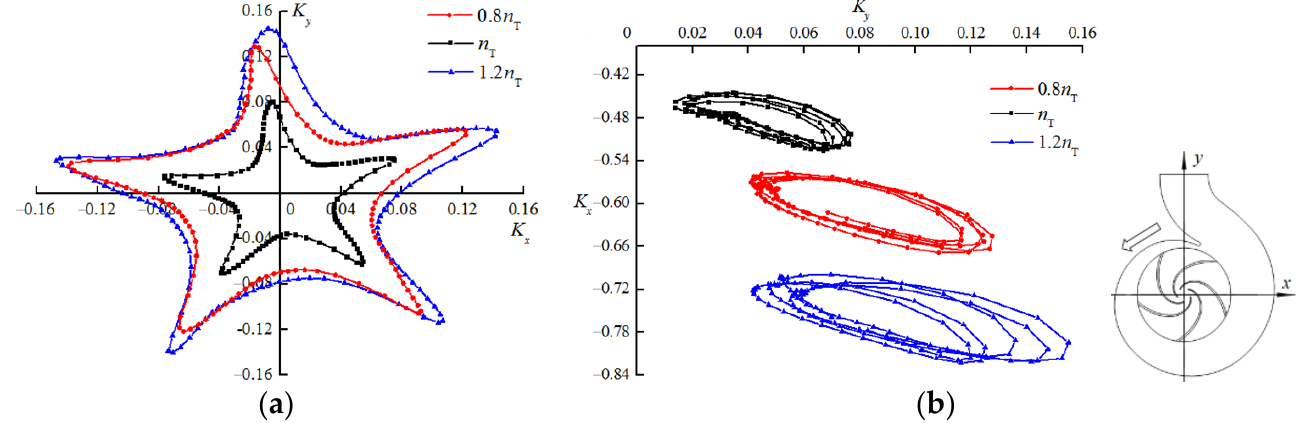
Figure 14. Radial hydraulic forces in one full working cycle. ( a ) Impeller. ( b ) Volute.